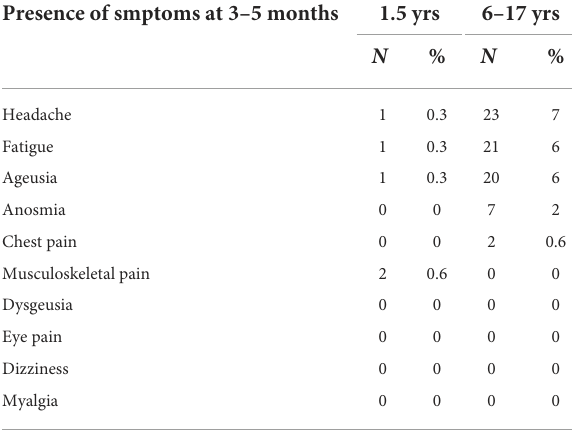
after 3–5 months in 7.5% of the sample. Fatigue (27.3% of TABLE 2 Descriptions and percentages of COVID-19 symptoms in the two subgroups 3–5 months after COVID-19